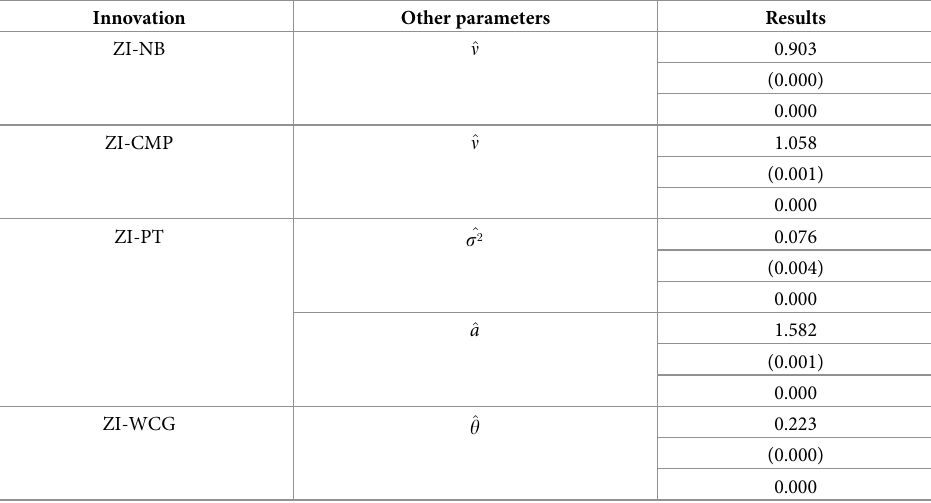
Table 3. Estimates, corresponding standard errors in parentheses and p-values.